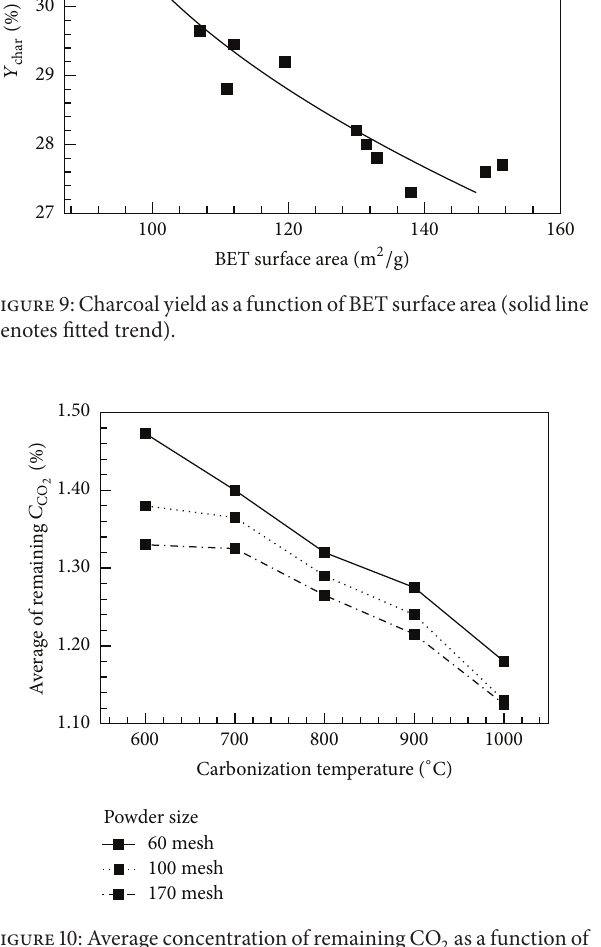
Figure 10: Average concentration of remaining CO 2 as a function of carbonization temperature for charcoal with various powder sizes.